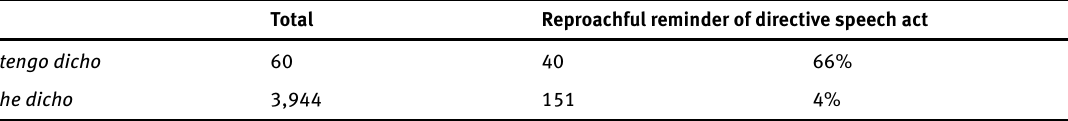
Table 2. Tengo dicho and he dicho as expressions of a reproachful reminder of a directive speech act Total Reproachful reminder of directive speech act